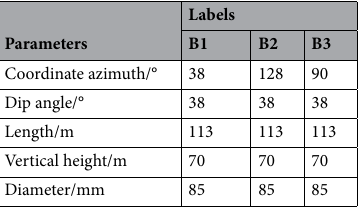
Table 2. Design parameters for detection